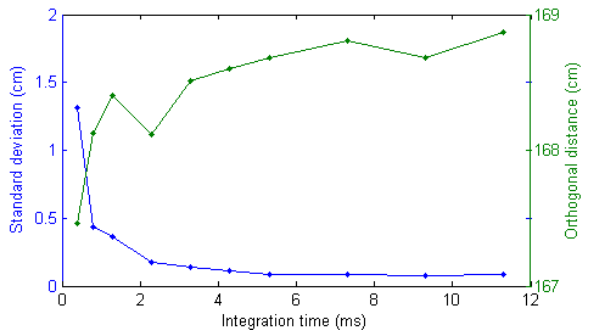
Figure 1. The relationship between integration time and standard deviation of distance. The measurement has been performed on the white wall from 167cm distance with setting 30 fps and 30 MHz modulation frequency (Altuntas, 2014) Integration time of SR4000 camera varies between 0-255